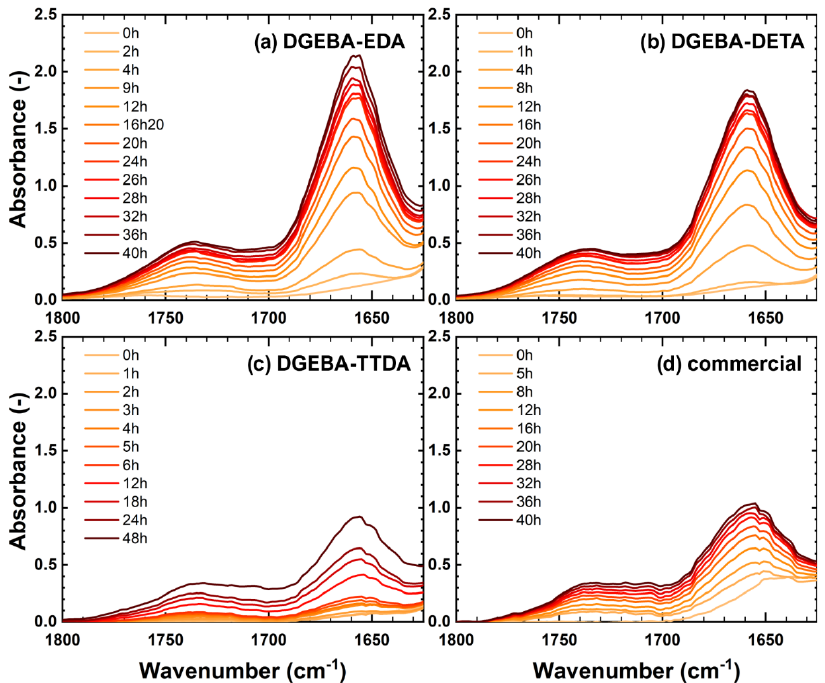
Figure 4. FTIR spectra in the carbonyl region for DGEBA-EDA ( a ), DGEBA-DETA ( b ), DGEBA- TTDA ( c ) and commercial epoxy ( d ) aged at 160 °C in ventilated ovens. ( c ) and commercial epoxy ( d ) aged at 160 ◦ C in ventilated